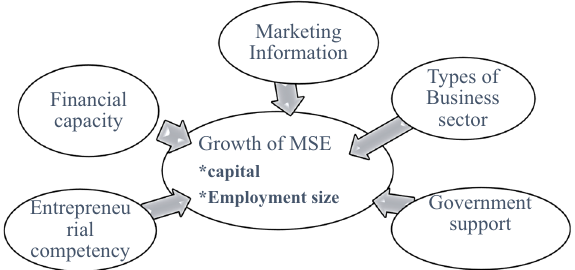
Fig. 1 Conceptual framework of the study. Source: compiled from the literature